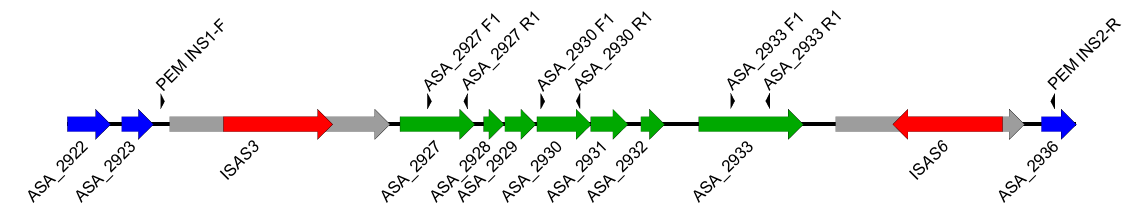
Figure 3. Map of the chromosomal region of the A449 strain where the ASA_2927 to ASA_2933 genes are found. These genes are specific to strains that can lose their TTSS locus. The ASA_2927 through ASA_2933 genes are shown in green. A gene encoding a putative integrase (in gray on the left of the figure) is interrupted by an IS AS3 , an IS (in red). Another gene (in gray on the right of the figure), coding for a hypothetical protein, is interrupted by IS AS6 , another IS (in red). The arrowheads above the genes indicate the position of primers used in genotyping PCR.